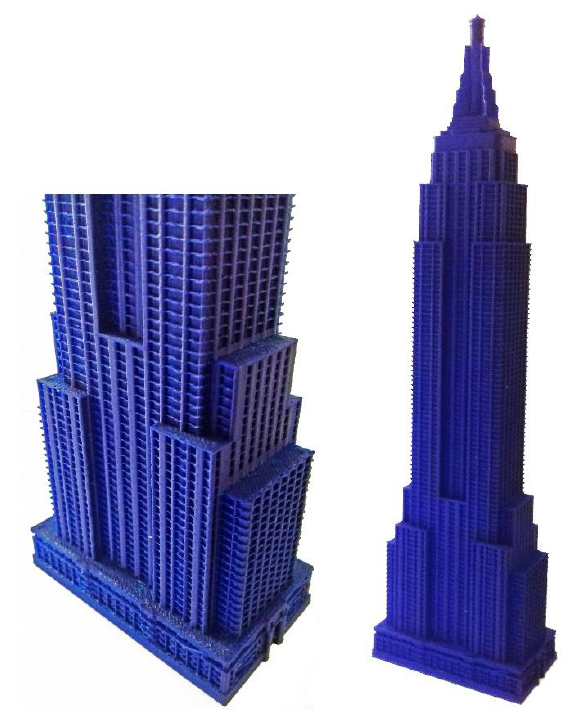
Figure 18. 3D print of the Empire State Building model The process prints layer by layer, for a total time variable in relation to the complexity of the object shape. The chamber is then progressively cooled to ambient temperature. The final operation consists in the mechanical removal of the support material.